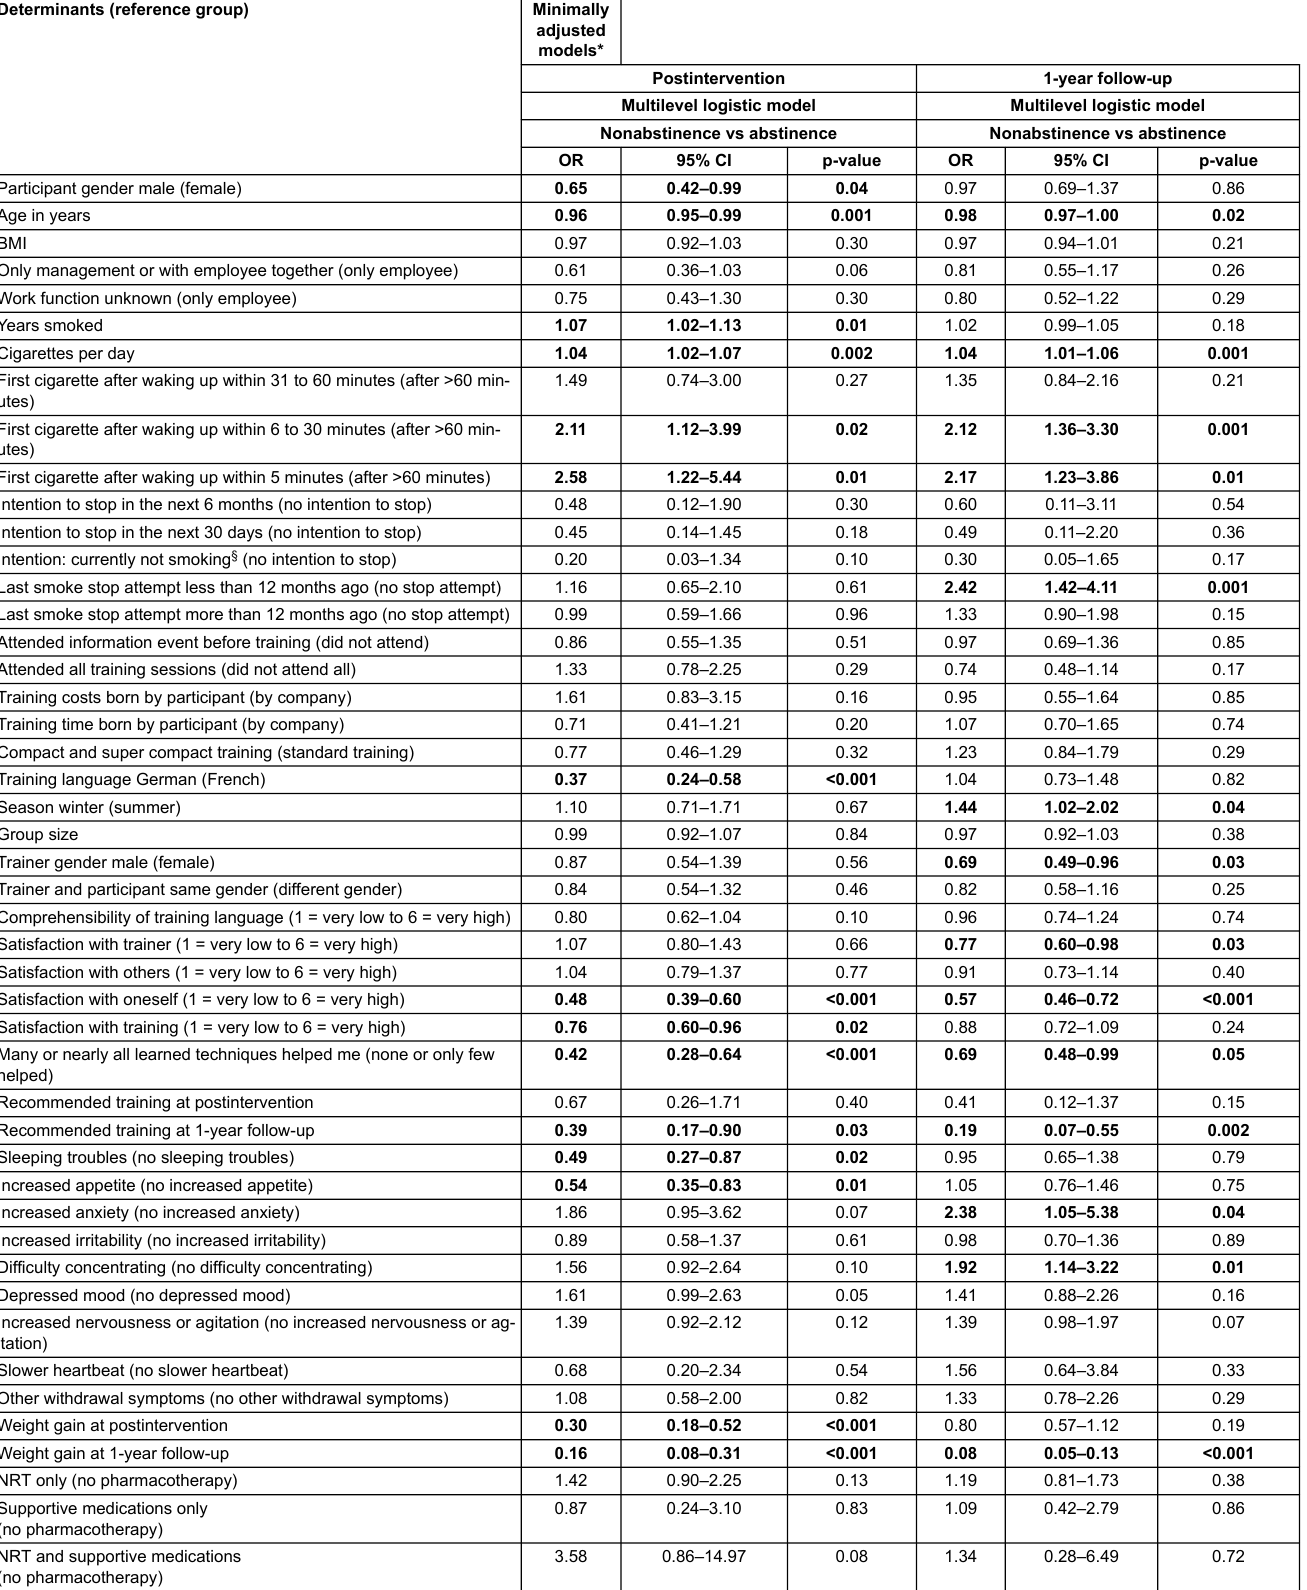
Table S1: A: Independent determinants of nonabstinence in minimally adjusted